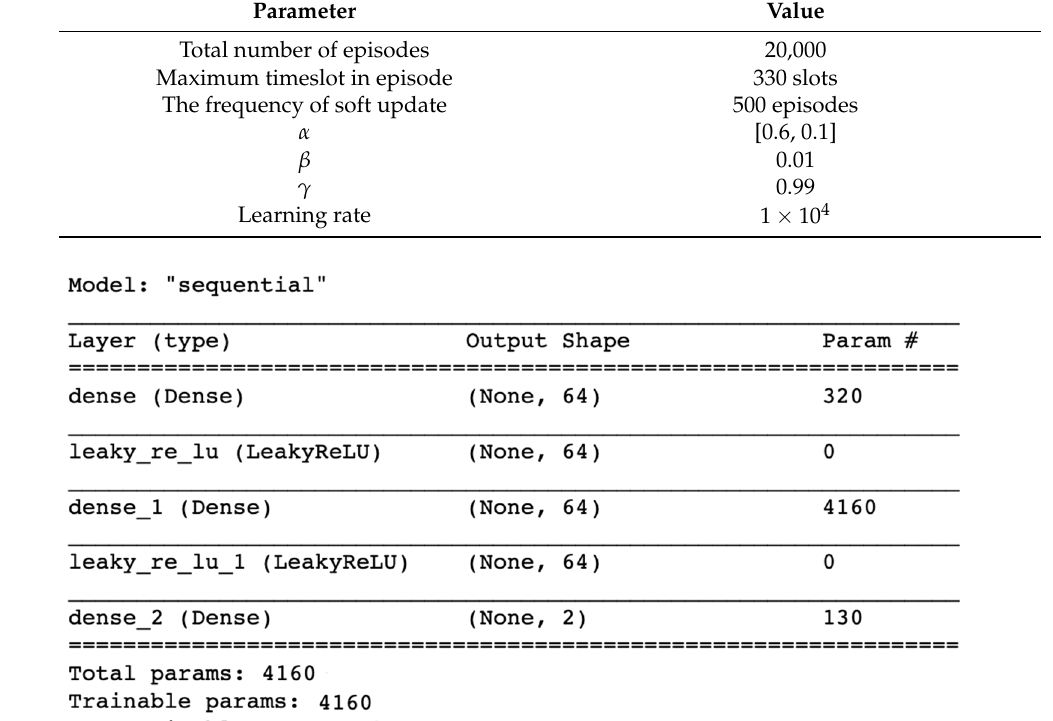
Table 5. DDQN parameters for training the model.